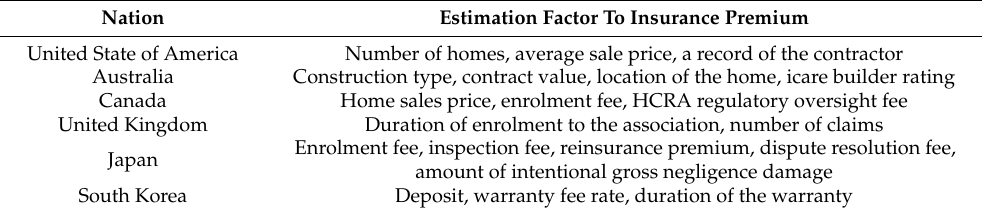
Table 1. Comparison of warranty programs.